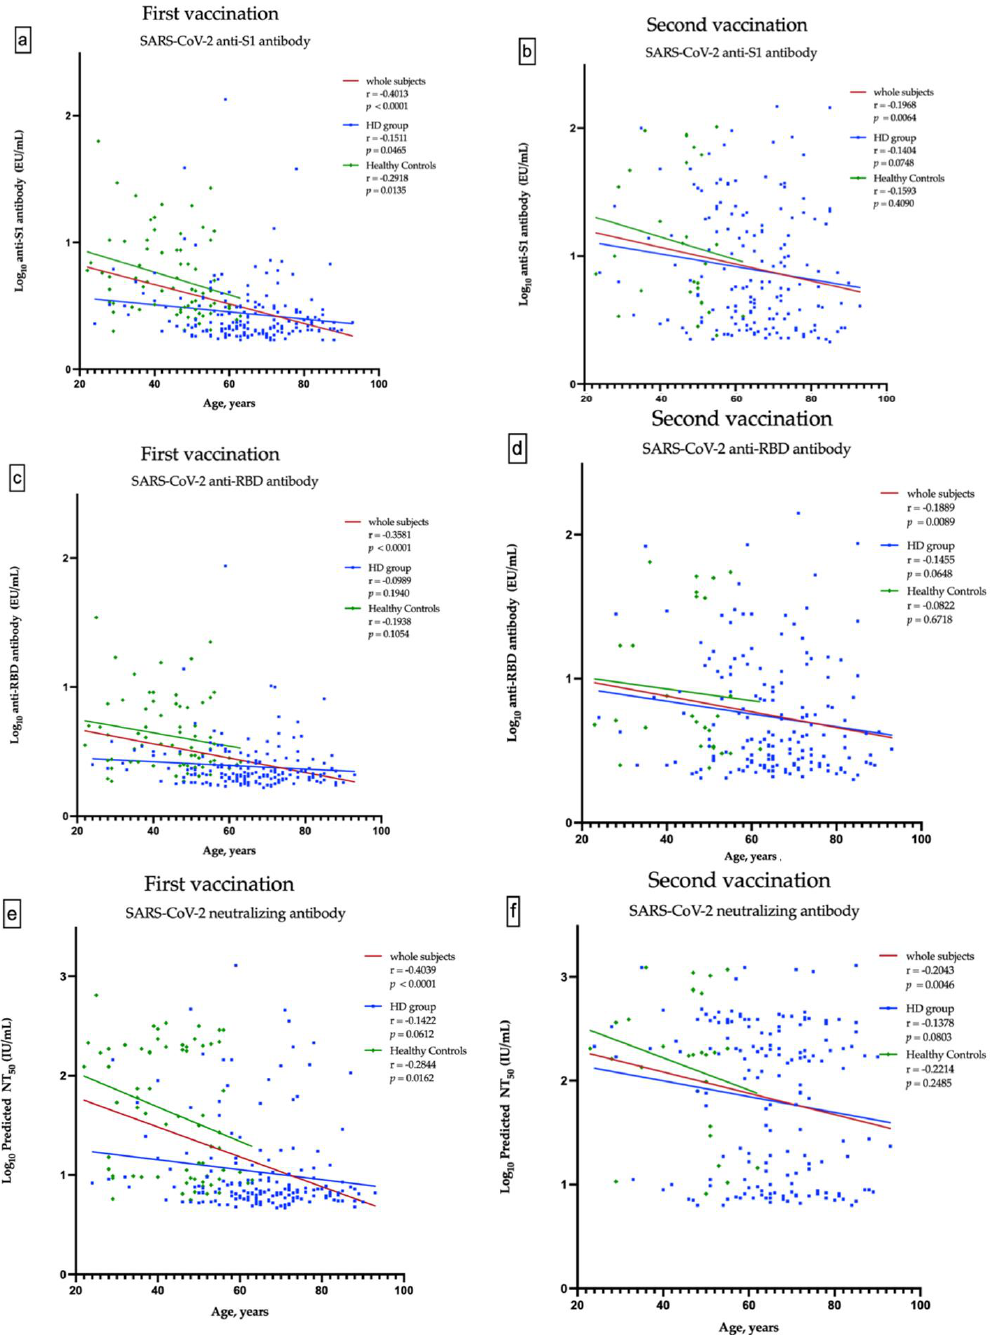
Figure 2. Correlation between the age and anti-S1 antibody after the first and second vaccination ( a , b ), between the age and anti-RBD antibody after the first and second vaccination ( c , d ), and between the age and predicted SARS-CoV-2 50% neutralization titer (NT 50 ) after the first and second vaccination ( e , f